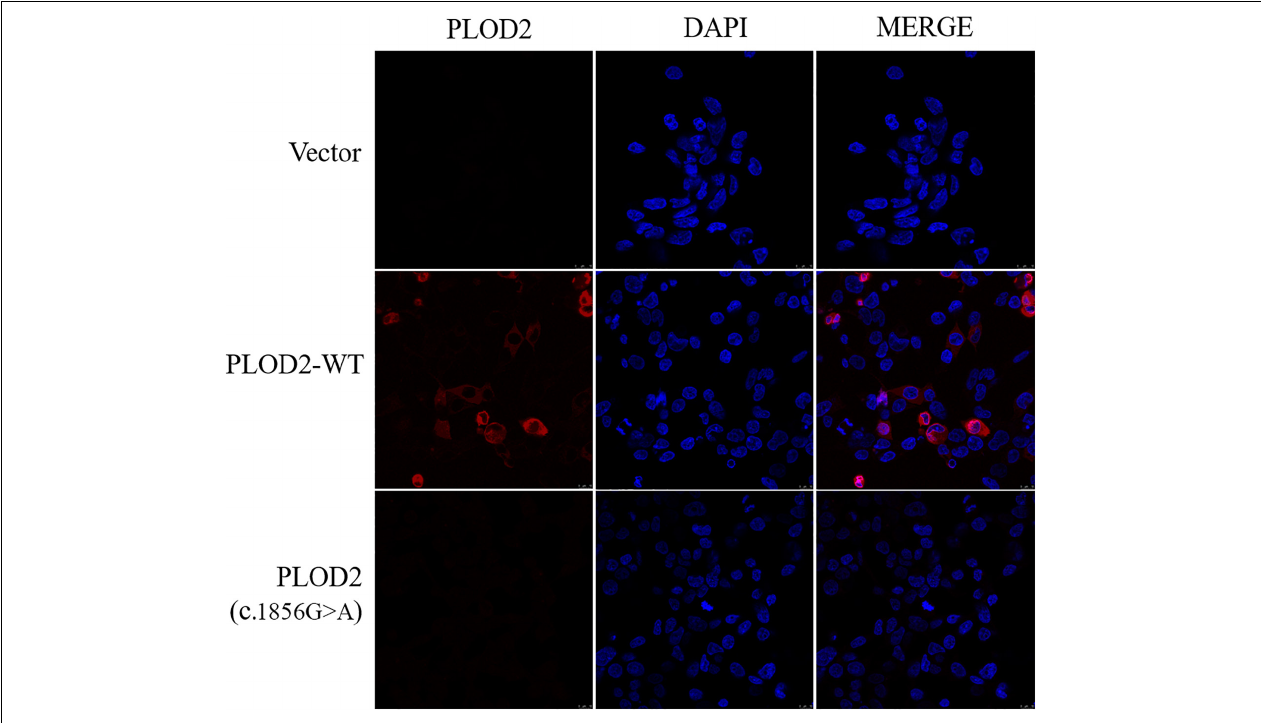
FIGURE 3 | Immunofluorescence was used to detect the localization of PLOD2 protein carrying empty type (Vector), wild type ( PLOD2 -WT), and PLOD2 p.Arg619His (c.1856G > A) variant in HEK293T cells. After c.1856G > A variant, the expression of PLOD2 protein was significantly downregulated.